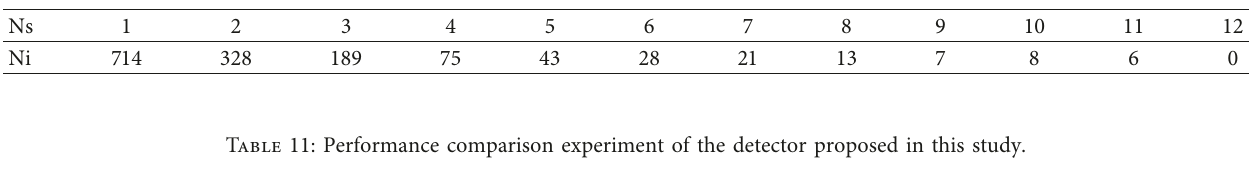
Table 10: Statistics of images and ships.